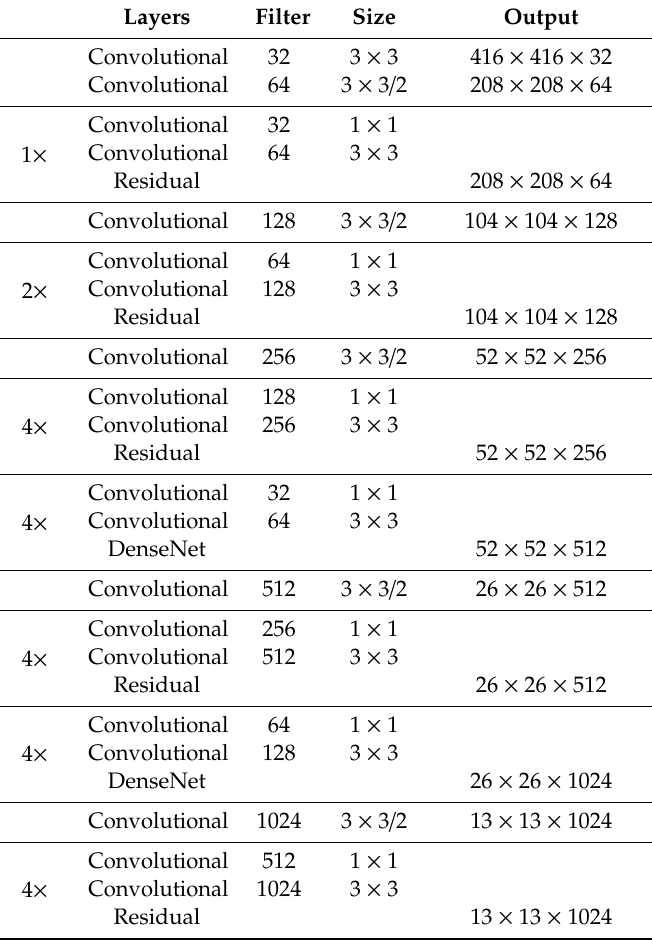
Table 2. The feature extraction network of our